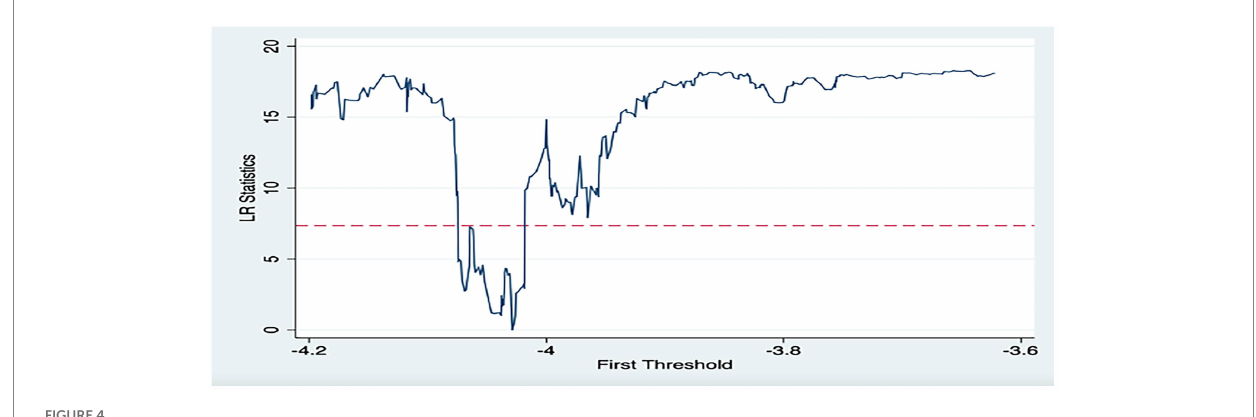
FIGURE 4 Likelihood ratio function of threshold effect